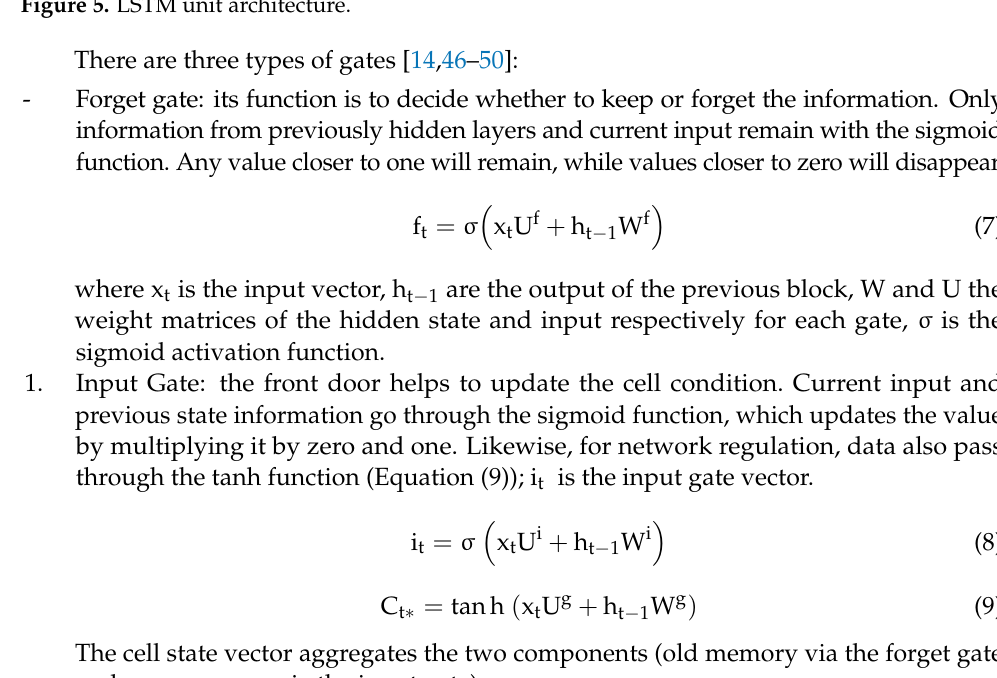
Figure 5. LSTM unit